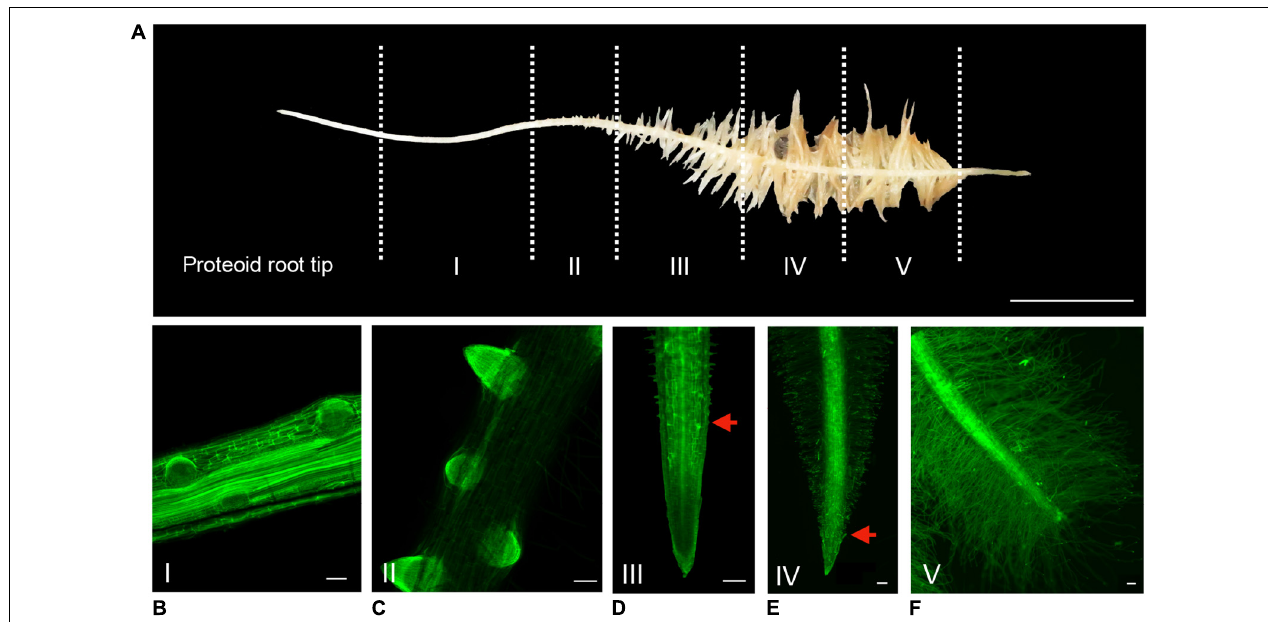
FIGURE 2 | Spatio-temporal evolution of rootlet development. (A) Division of a cluster into 5 stages of rootlet development. Calcofluor was used to stain 100- µ m thin longitudinal sections of rootlets at (B) Stage I: pre-emergence. (C) Stage II: emergence. (D) Stage III: growing. (E) Stage IV: rootlets having reached their maximal length. (F) Stage V: fully differentiated rootlets. Red arrows indicate the closest root hair from the tip. Scale bars: (A) 1 cm, (B–F) 100 µ